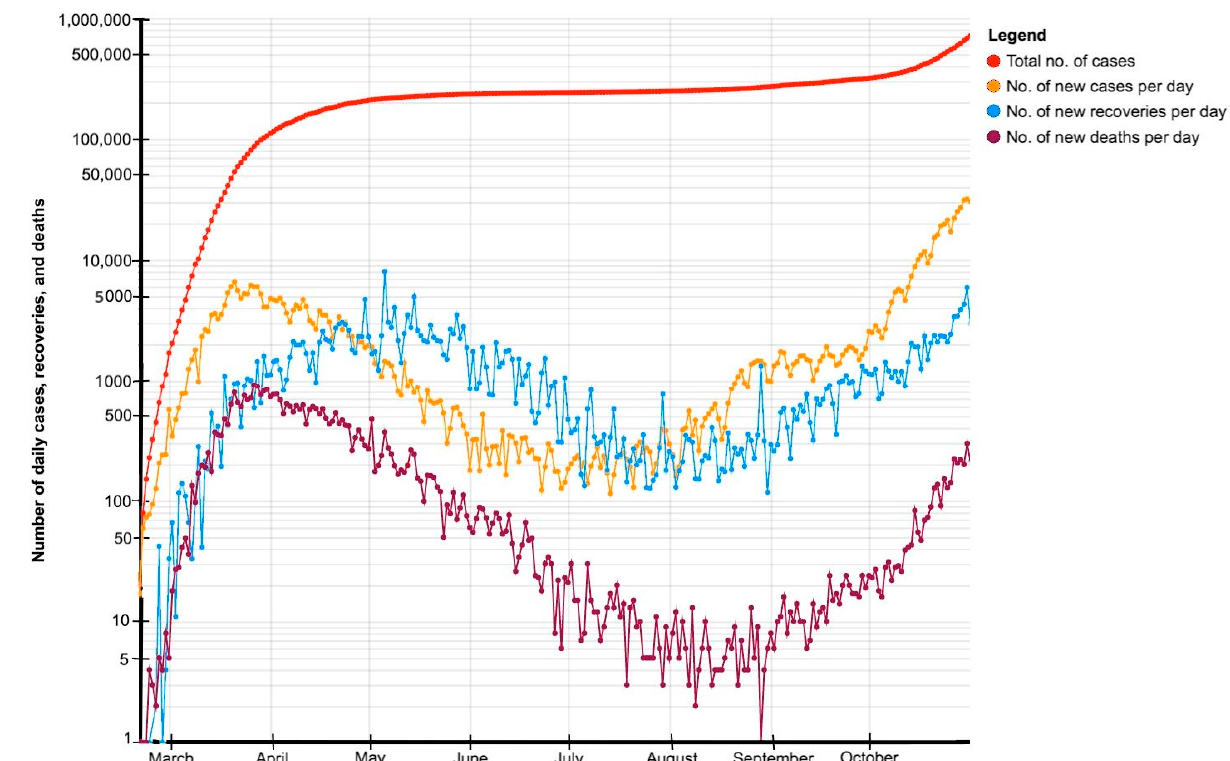
Figure 1. Development of the pandemic in Italy from 21 February to 31 October 2020. Note: Figure adapted from the article “Statistics of the COVID-19 pandemic in Italy” (available online at https://en.wikipedia.org/wiki/Statistics_of_the_COVID-19_pandemic_in_Italy (accessed on 16 May 2021).